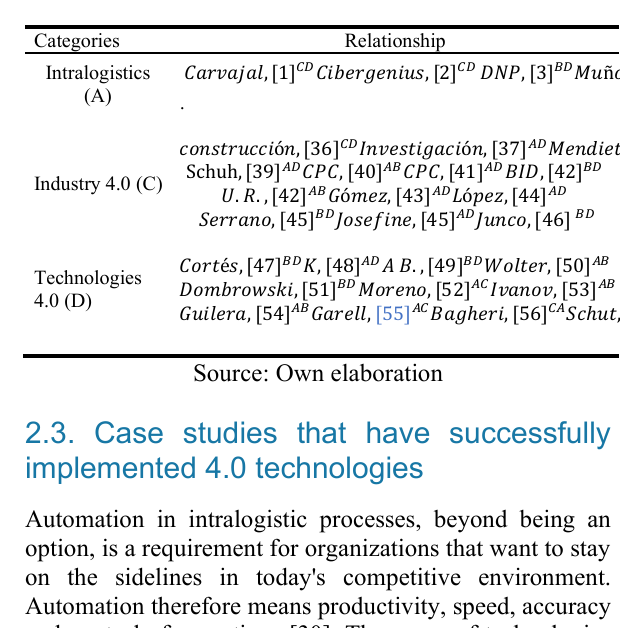
Table 1. Relationship between categories and